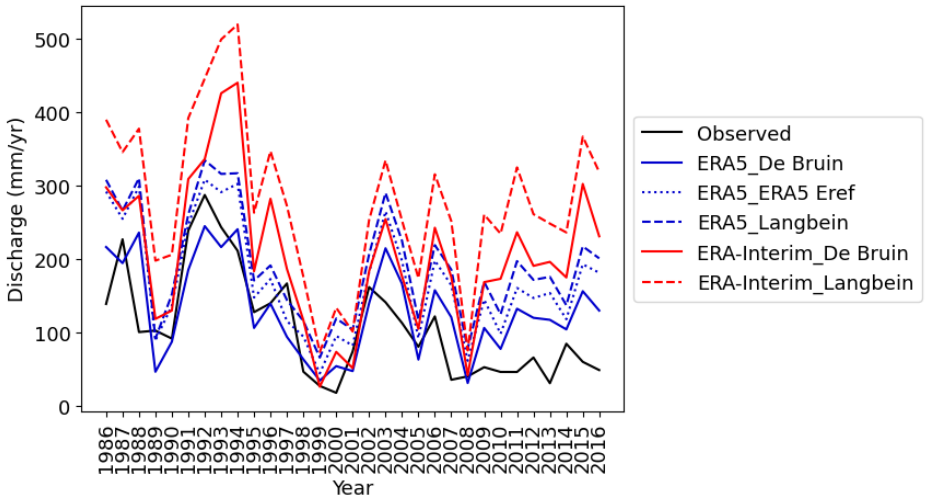
Figure 6. Estimated discharge by the GlobWat model using different weather datasets and Eref methods against observed ones over Urmia Lake Basin, Iran.